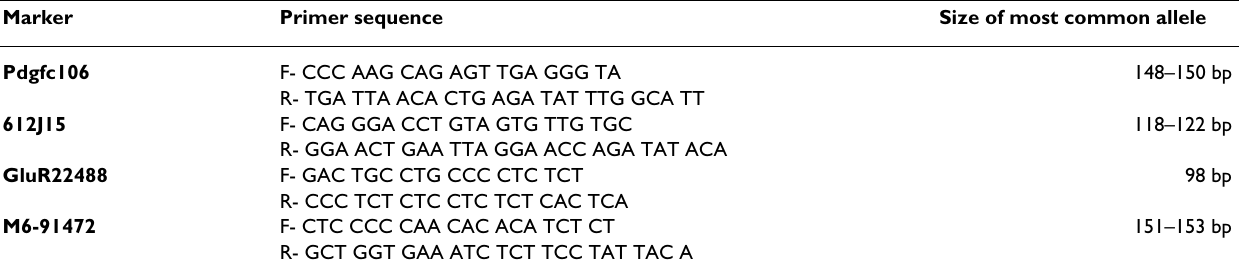
Table 1: New microsatellite repeat polymorphisms identified in the 4q32-4q34 region. Marker Primer